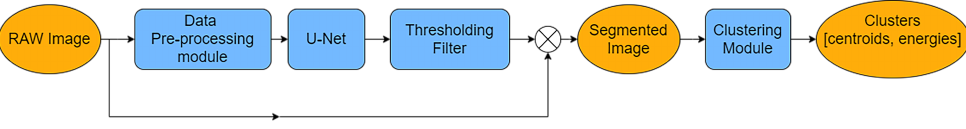
Figure 4. BOSS algorithm scheme: data are in orange, and modules are in light